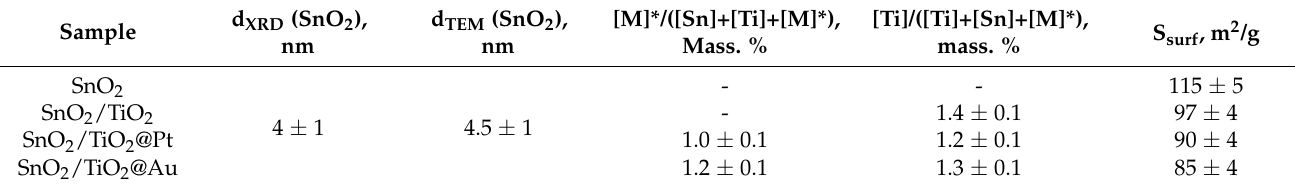
Figure 3. HAADF-STEM image and corresponding EDX mapping of the Sn, O, Pt, Ti signals of the SnO 2 /TiO 2 @Pt nanocomposite. Table 1. Microstructure characteristics and composition of investigated samples.